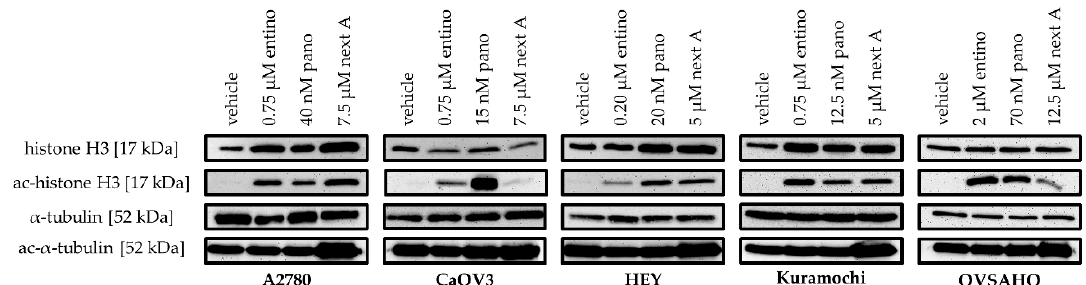
Figure 2. E ff ect of HDACi on acetylation level of α -tubulin and histone H3. Representative immunoblot analysis of histone H3, ac-histone H3, α -tubulin, and ac- α -tubulin in the di ff erent human ovarian cancer cell lines. Cells were treated with the indicated concentrations of HDACi. Control cells were incubated with vehicle. One representative immunoblot with a protein molecular weight marker is shown in Figure